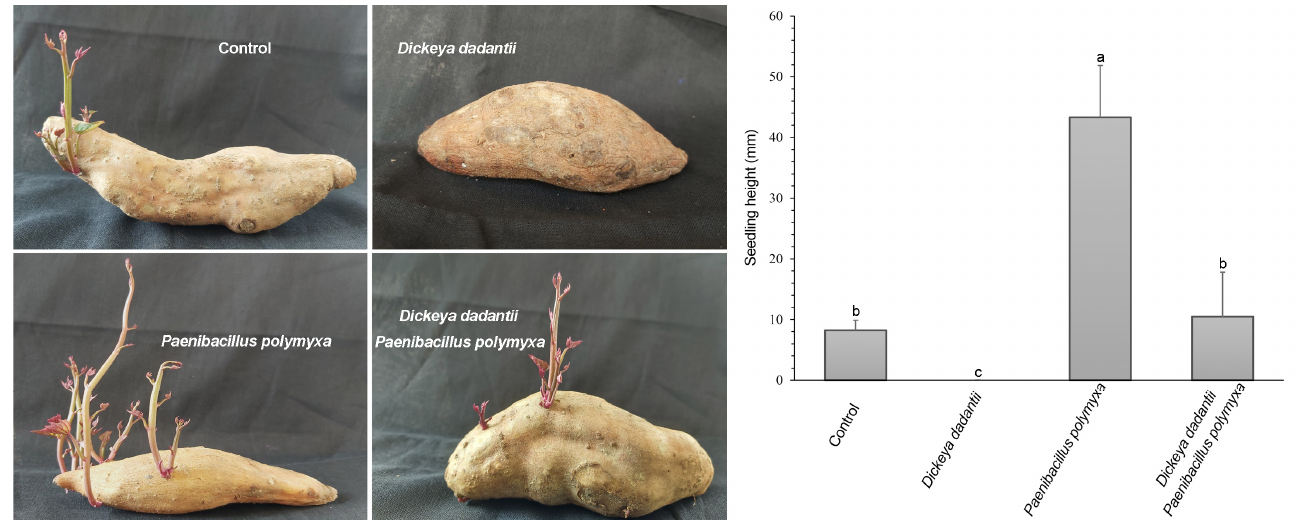
Figure 1. Sweet potato seed tubers and seedlings at 21 d after inoculation with water, Dickeya dadantii CZ1501, Paenibacillus polymyxa ShX301, or both D. dadantii and P. polymyxa . Vertical bars represent the standard errors of mean values ( n = 6). Different letters on the bars indicate a significant difference between the treatments at p < 0.05.